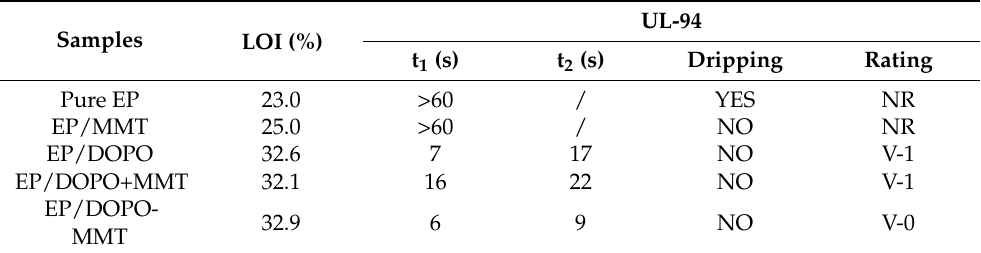
Table 1. Flame-retardant properties of